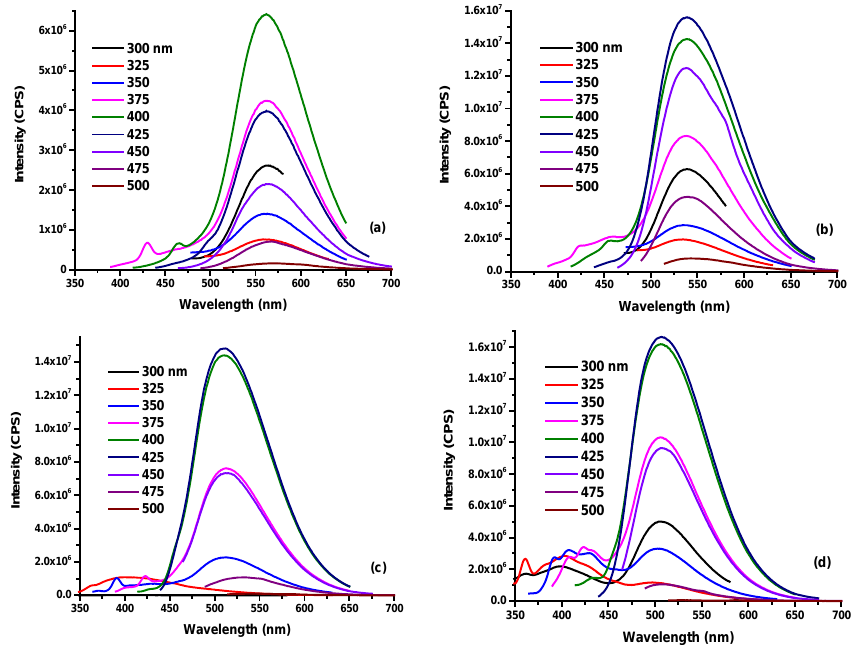
Figure 4. The fluorescence emission spectra of O-CDs dispersed in various solvents. (0.15 mg/mL) (( a ) water, ( b ) methanol, ( c ) acetone and ( d ) tetrahydrofuran).